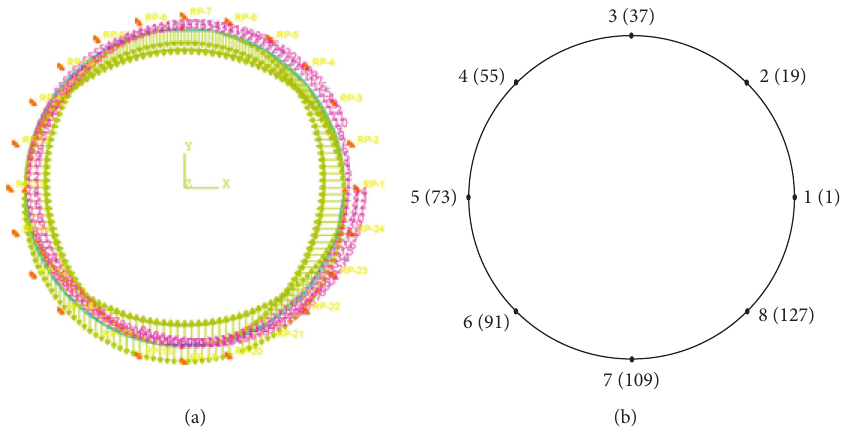
Figure 8: Forward analysis calculation model. (a) Finite element model. (b) Layout of measuring points and node